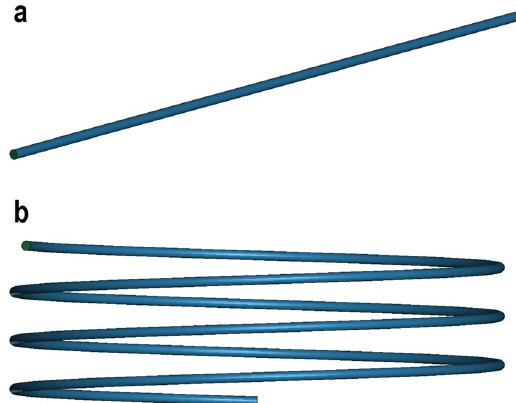
Figure 5. 3D sketches of the tubes shear zones where ( a ) is the straight S1-version and ( b ) is the helical coil tube called S2. Both tubes had a diameter of 2 mm and length 1000 mm. The helical coil tube had a helix diameter of 100 mm with a pitch of 10